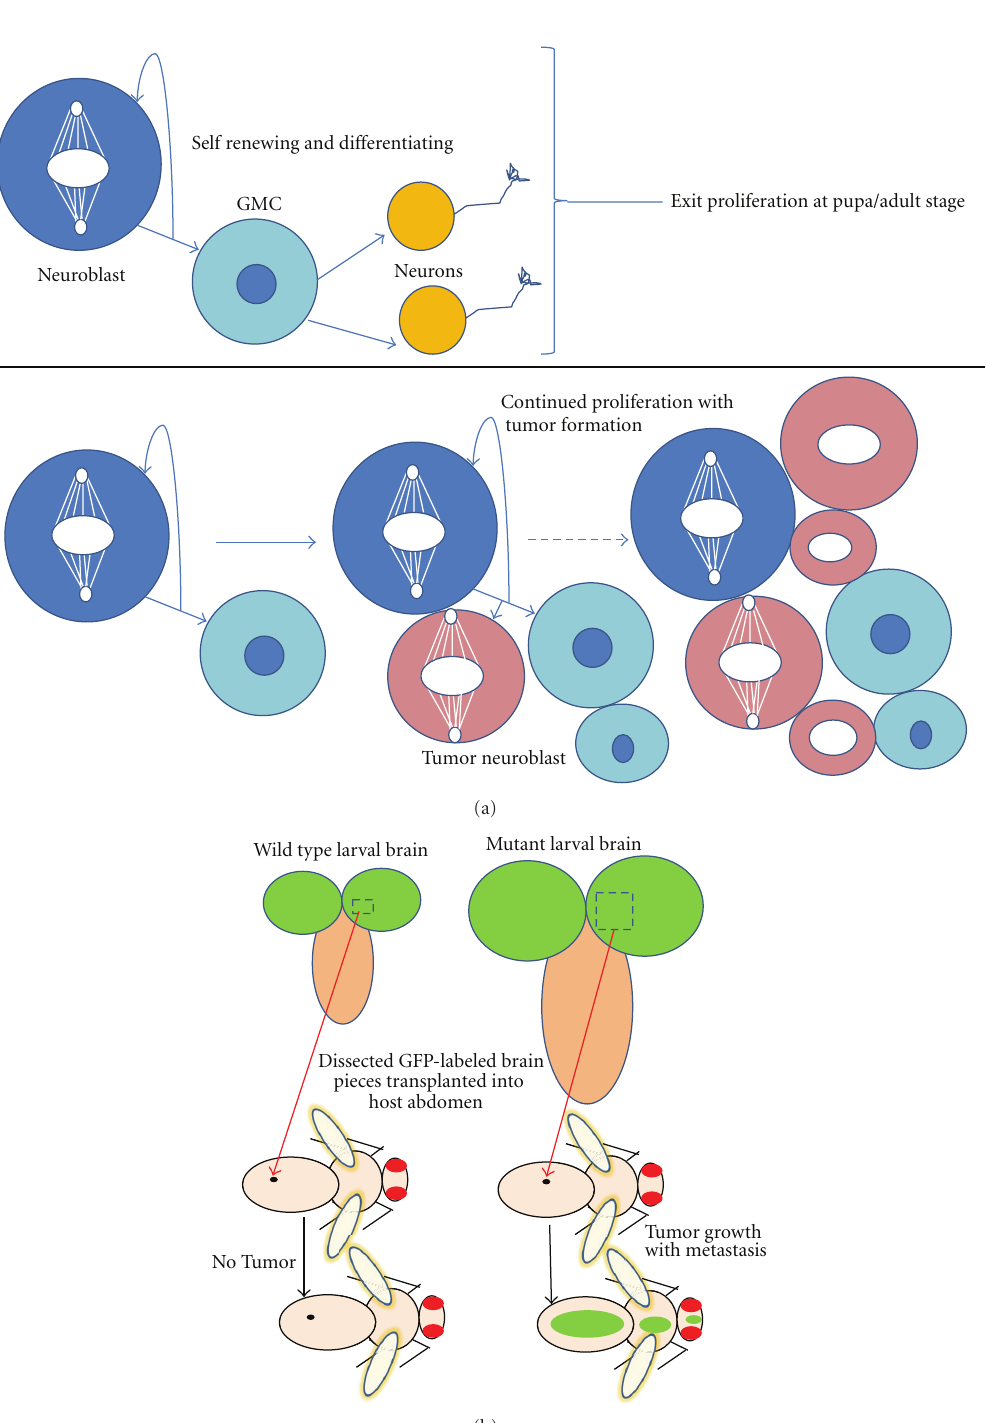
Figure 5: Abnormal neuroblast proliferation and brain tumor formation. (a) (Top), wild-type Drosophilae have “normal neuroblasts” which undergo a regulated self-renewal and di ff erentiation process to generate neurons or glial cells. This proliferation exits at pupal stage. (Bottom), Dysregulated asymmetric cell division in central brain neuroblasts of larval brains with knockdown or knockout of cell-fate determinants results in brain tumor formation [24, 29–32]. The disturbed balance between self-renewal and di ff erentiation results in the generation of self-renewing “tumor neuroblasts” and indefinite proliferation. (b) (Left) wild-type larval brain compared to (right) cell fate determinant ( brat / prospero / numb ) mutant, overproliferated brain. Transplantation of dissected GFP-labeled neuroblasts from the latter results in tumor formation in host flies and subsequent metastasis